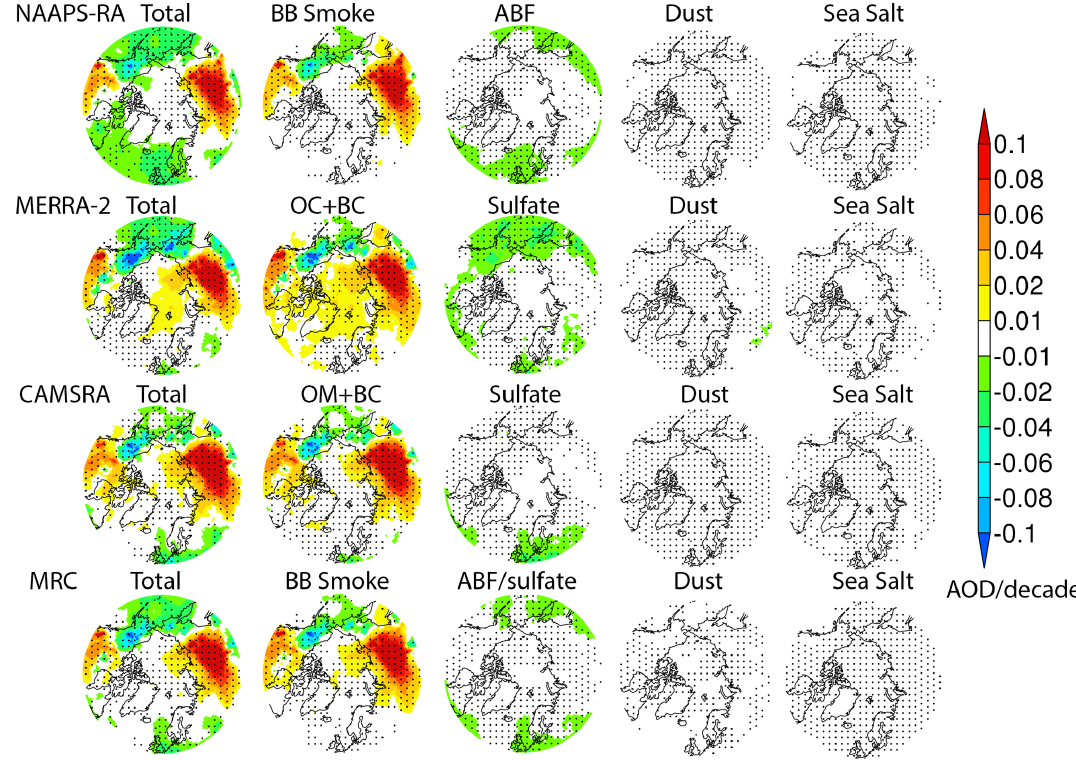
Figure 11. Same as Fig. 10 except for